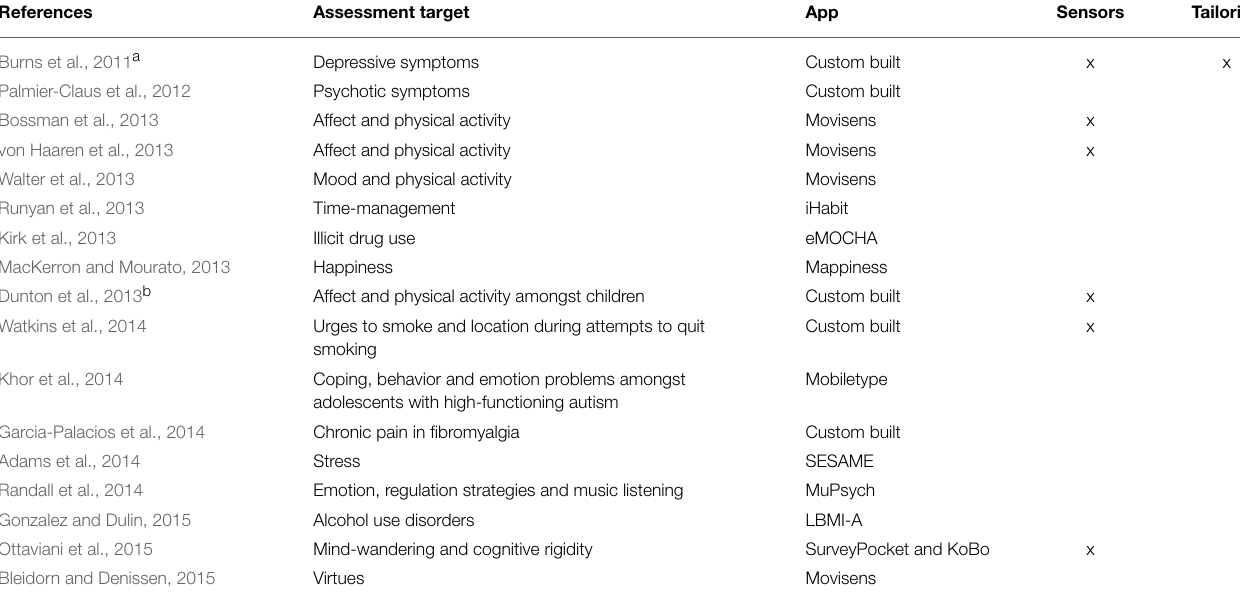
TABLE 1 | EMA peer-reviewed psychological studies using smartphone